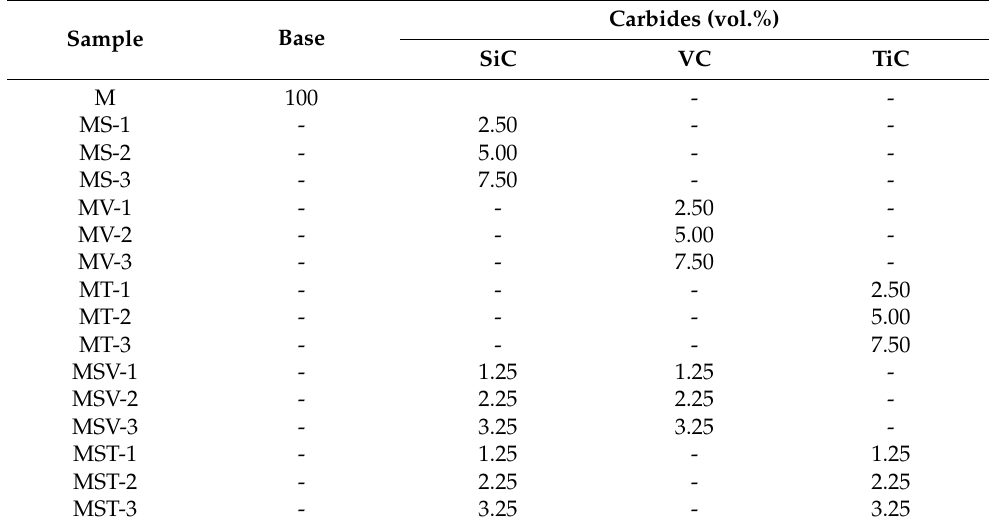
Table 4. The volume fraction of MC-type carbides in various designed HSS MMCs.